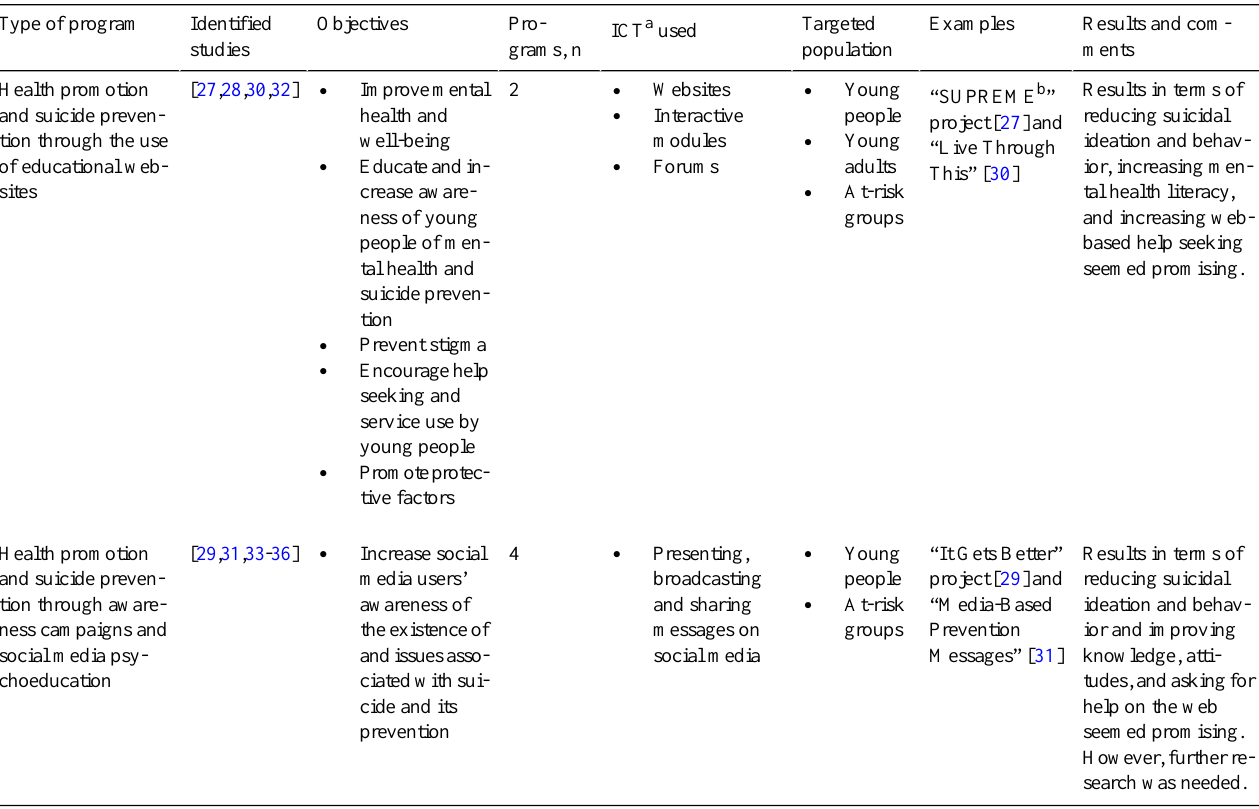
Table 1. Universal suicide prevention